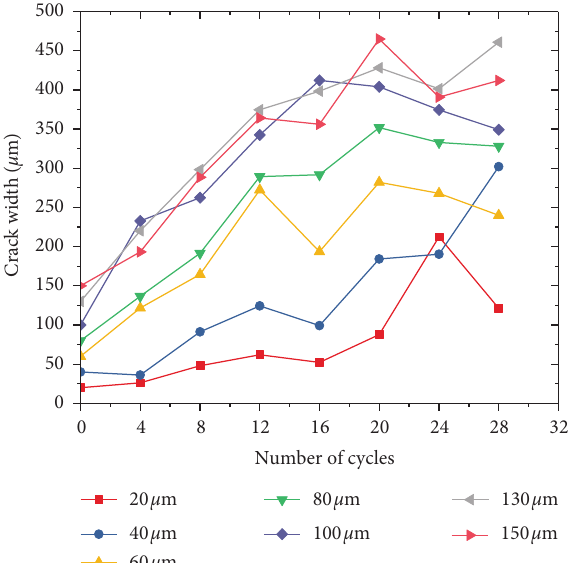
Figure 5: The fracture development of the specimens under different salt-freezing